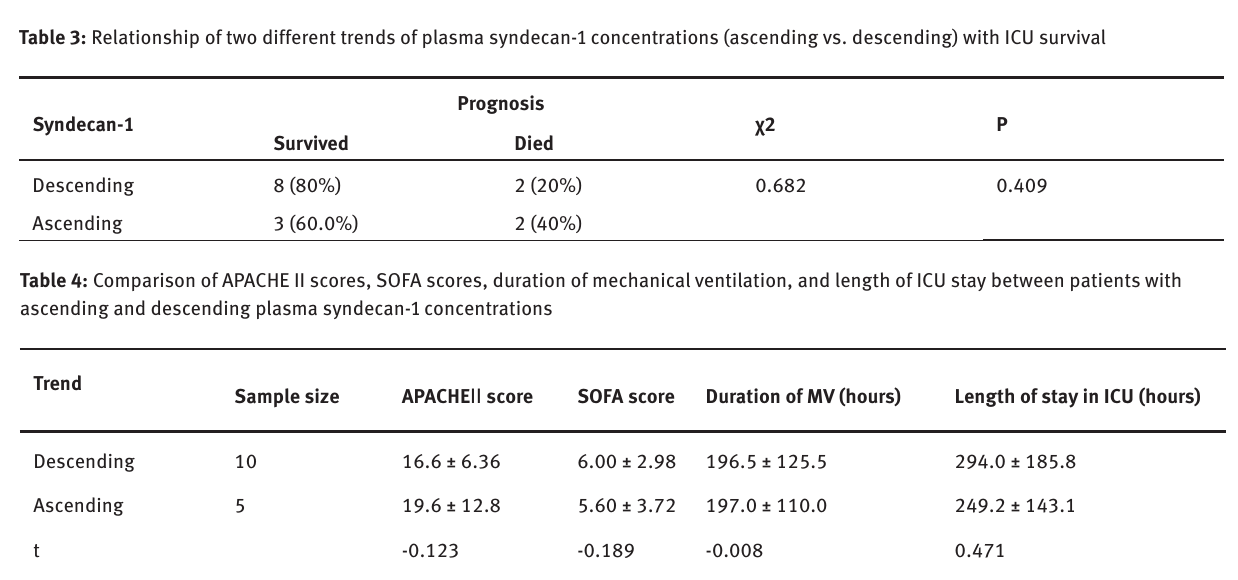
Table 3: Relationship of two different trends of plasma syndecan-1 concentrations (ascending vs. descending) with ICU survival